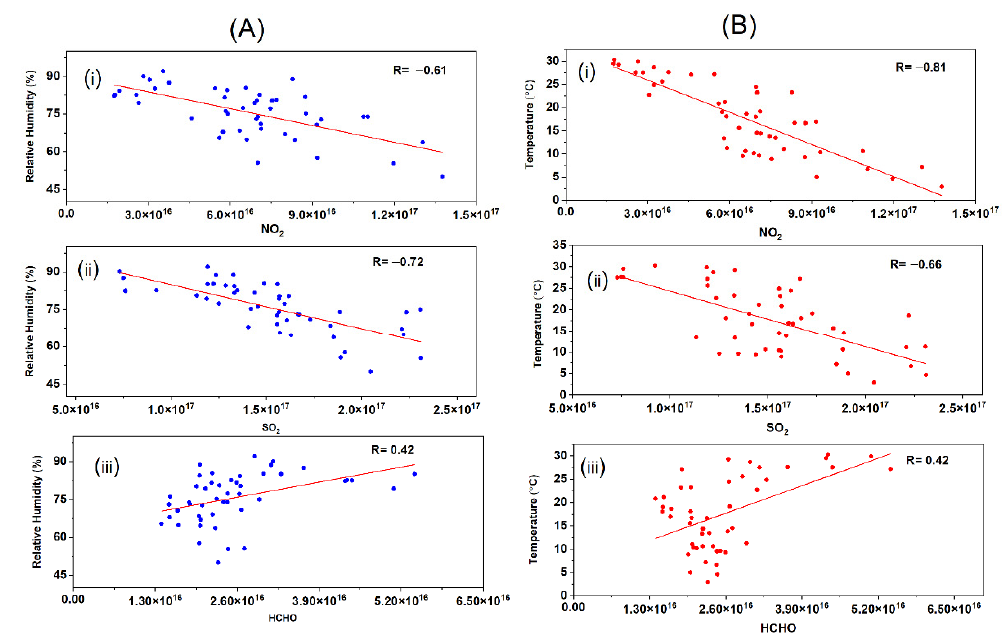
Figure 6. Relationship of RH ( A ) and T ( B ) with weekly averaged ( i ) NO 2 , ( ii ) SO 2 , and ( iii )